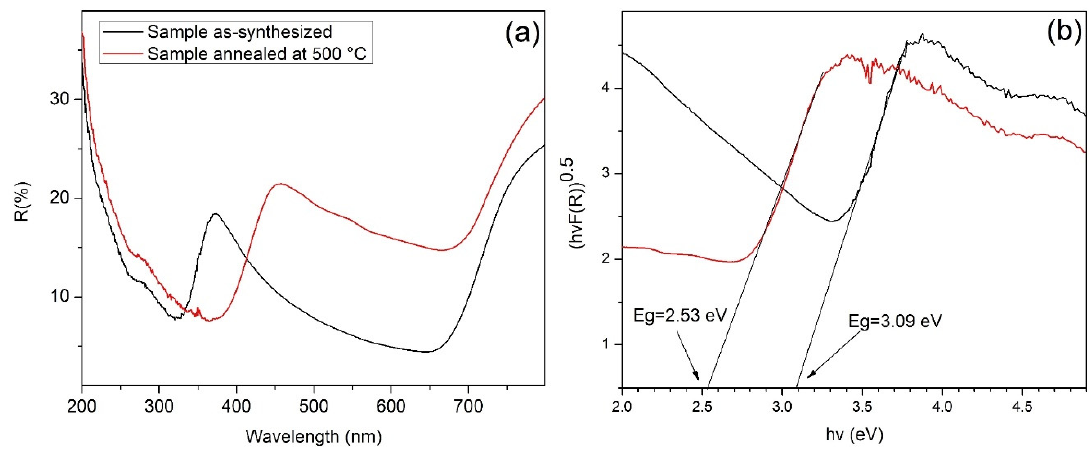
Figure 8. ( a ) Diffuse reflectance spectra and ( b ) Tauc plots for the as-synthesized and annealed samples.